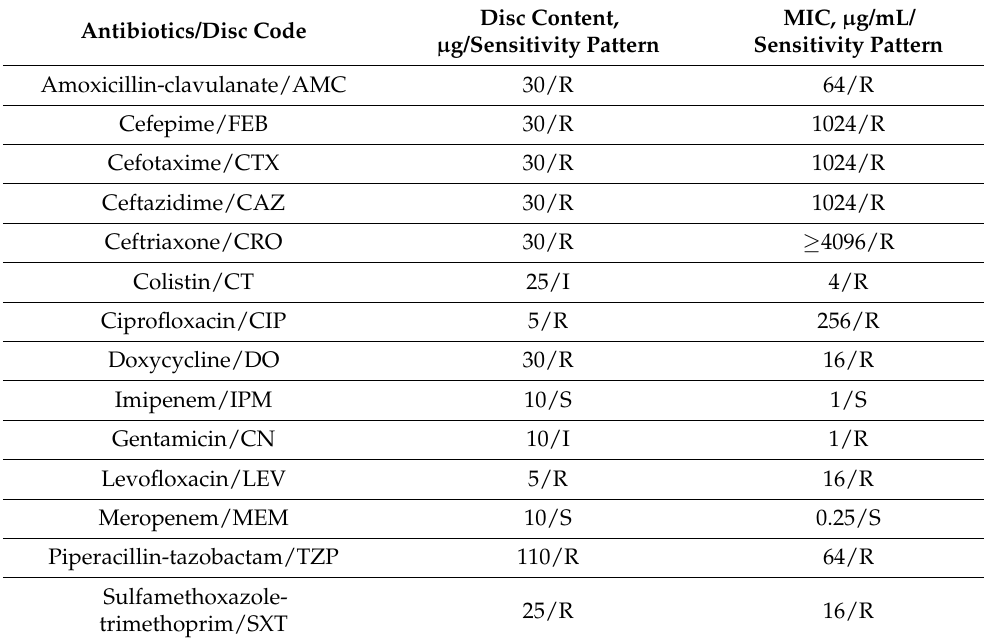
Table 1. Antimicrobial susceptibility profile of E. coli strain EC14142 from Egypt.